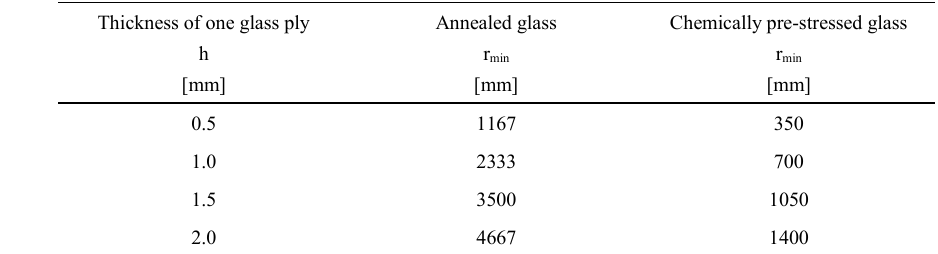
Table 1: Minimum radii r min of glass.